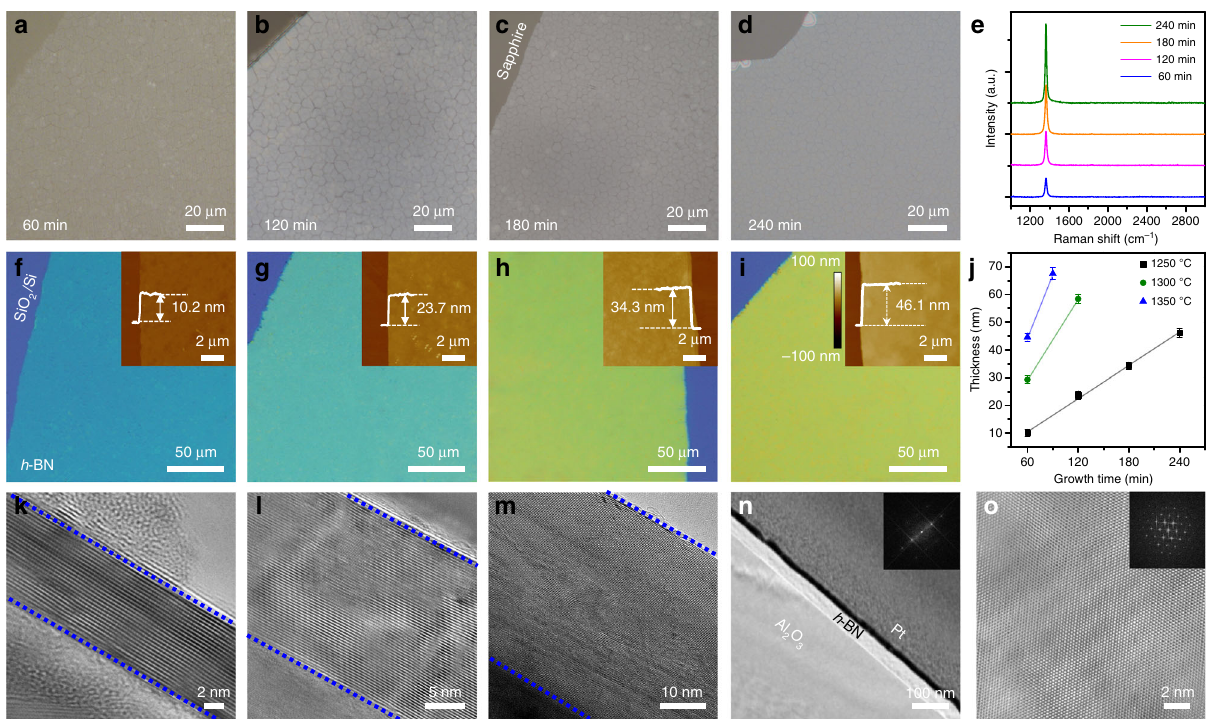
Fig. 2 Controllable thickness of large-area multilayer h -BN on sapphire. a – d , Typical OM images of multilayer h -BN grown on sapphire with 60 ( a ), 120 ( b ), 180 ( c ) and 240 ( d ) minutes at 1250 °C. e Corresponding Raman spectra of multilayer h -BN with different growth times. f – i Corresponding to ( a – d ), multilayer h -BN are transferred onto SiO 2 (300 nm)/Si substrate. The inset shows the corresponding AFM images. j Relationship between growth time and thickness of multilayer h -BN. Error bars for the experimental data represent standard deviation uncertainty of thicknesses collected from different samples. k – n Corresponding TEM images of multilayer h -BN with different thicknesses. o Typical TEM image and FFT pattern (inset) of multilayer h -BN.